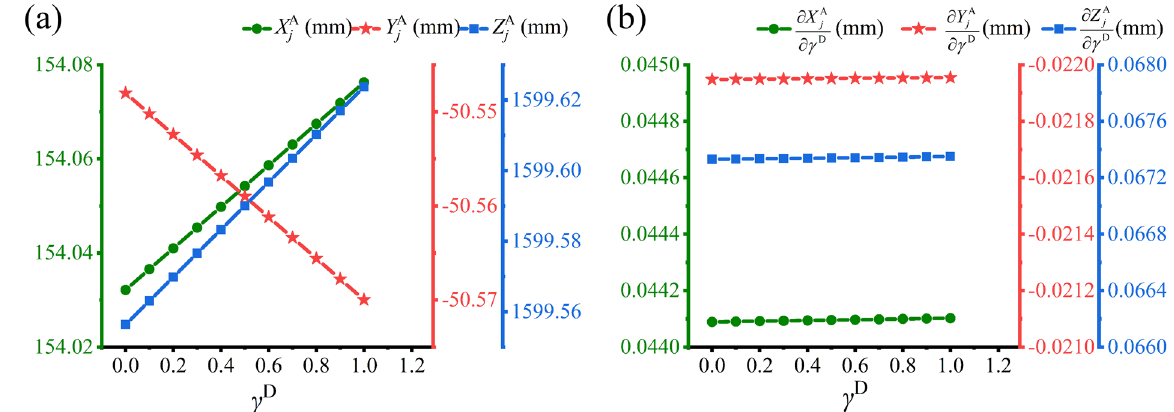
Figure 7. Simulation results of the intrinsic parameters γ D . ( a ) The relationship between the coordinates X A Y A Z A j , j , j and the intrinsic parameter ∂ Y A /∂γ D , ∂ Z A /∂γ D and the intrinsic parameter γ D j j